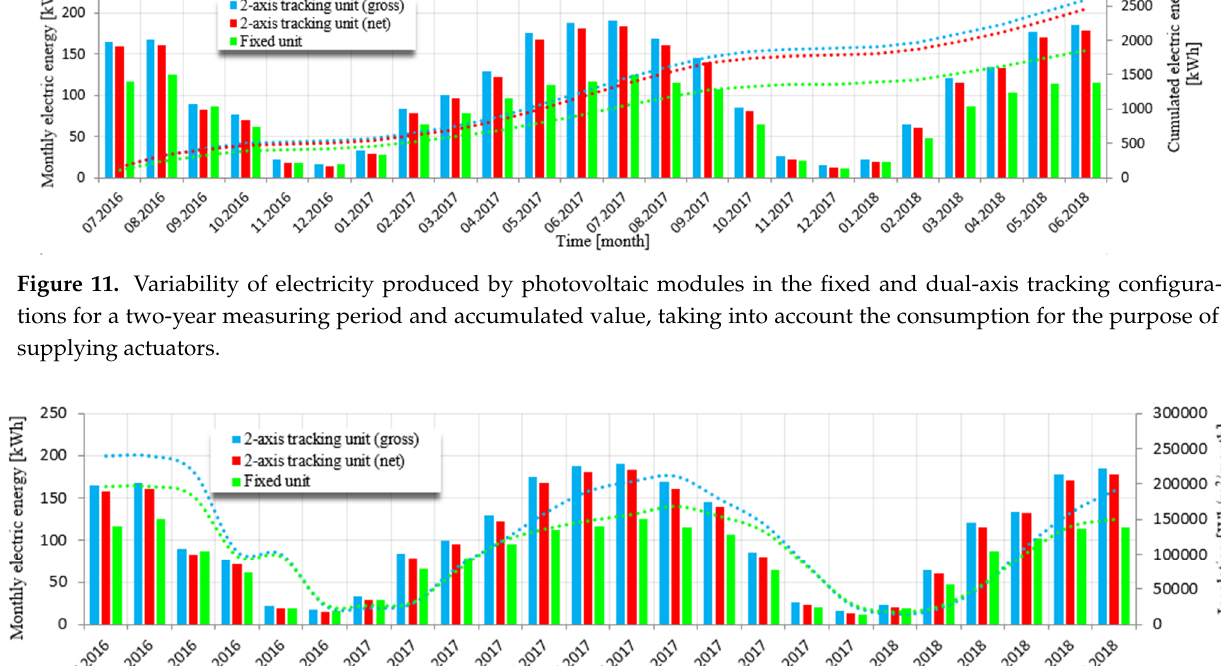
Figure 13. Variability of the electricity production and the determined insolation for photovoltaic modules in the fixed and dual-axis tracking configurations in July 2016.